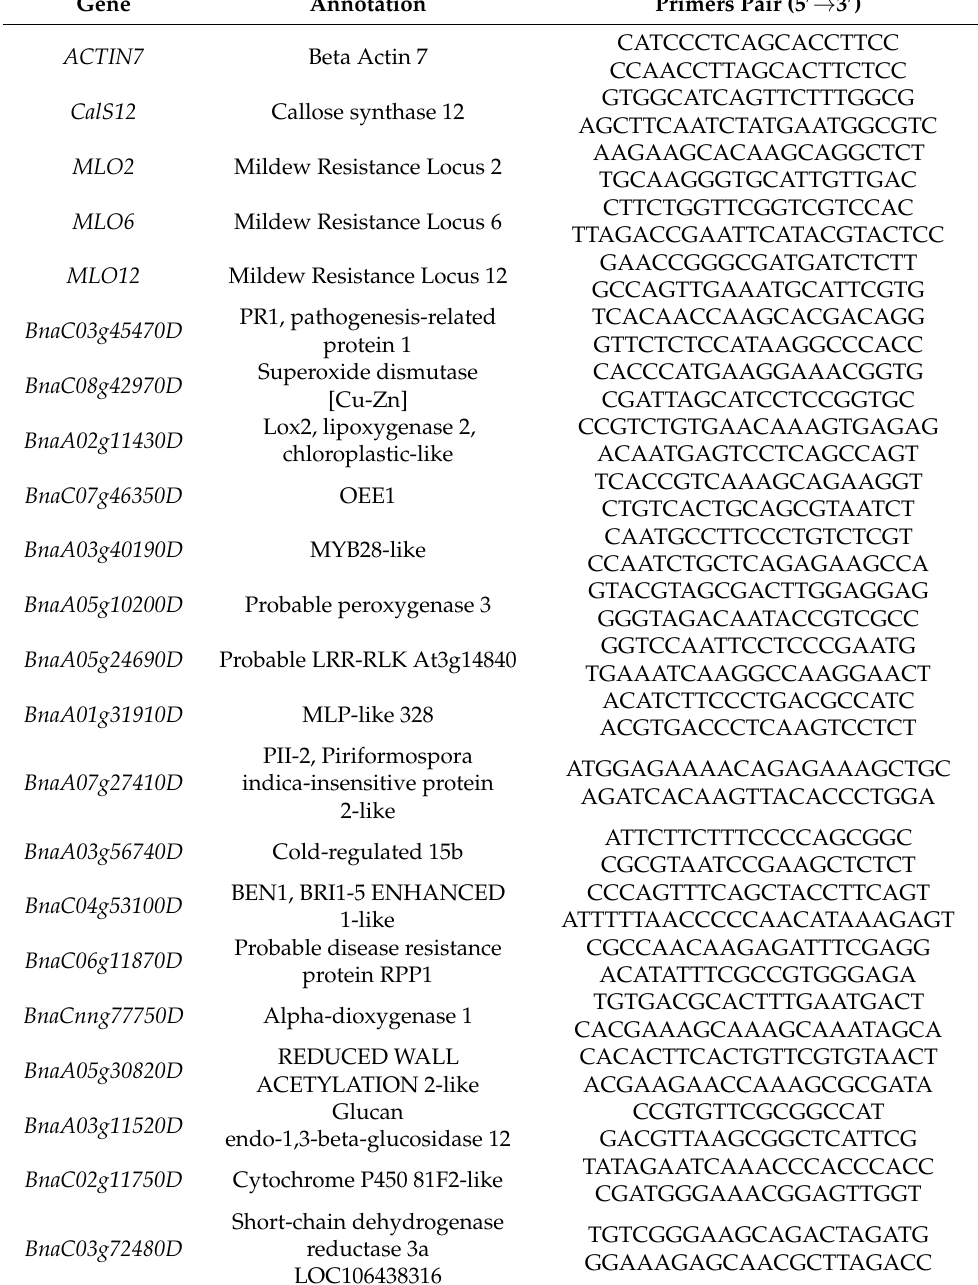
Table 1. The primers designed for qPCR test of the selected genes.